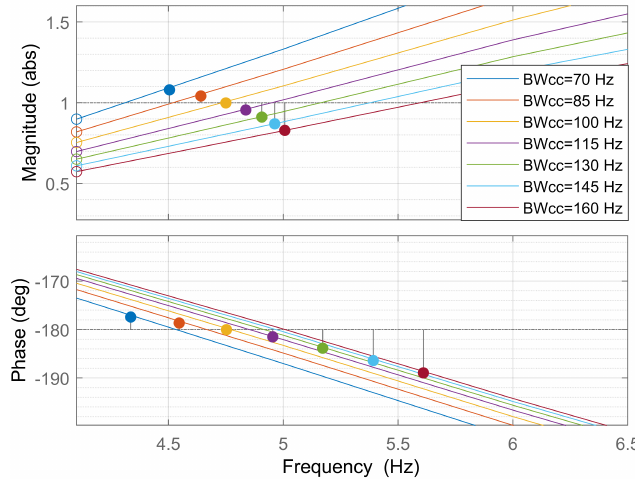
Figure 10. Bode diagram of the system eigenvalue λ 1 . Variation of current controller bandwidth.